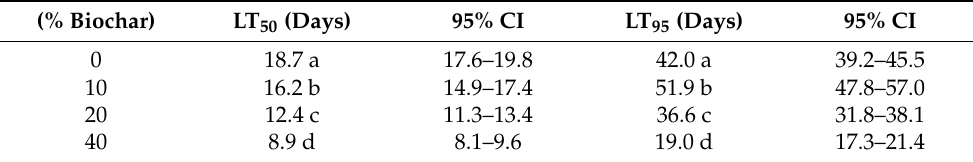
Table 2. Lethal time (LT) estimates to 50% and 95% mortality (maximum likelihood) with 95% con- fidence intervals (CI) for O. pseudotsugata larvae reared on synthetic diet mixed with multiple con- centrations of dry biochar material by volume. Within a column, estimates of probability of mortal- ity followed by the same letter are not significantly different.